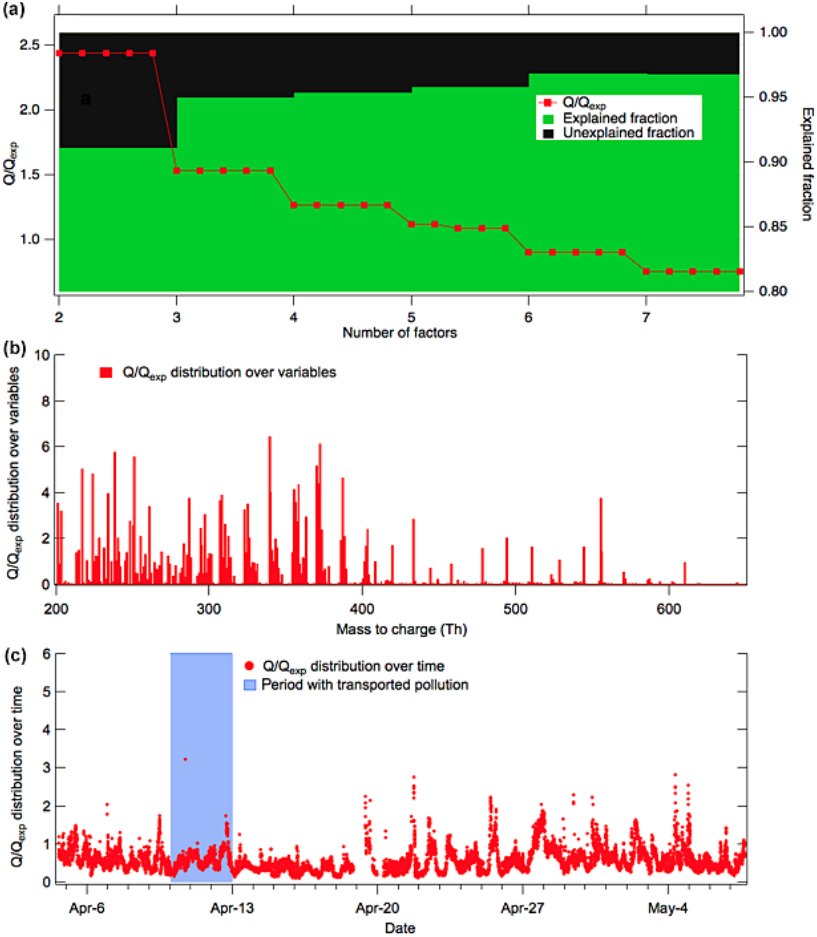
Figure 7. Mathematical diagnostics of PMF solutions, including the overall changes of Q/Q exp and the explained variation from two-factor to seven-factor solutions. For each number of factors, five seed runs were performed to test the consistency of the